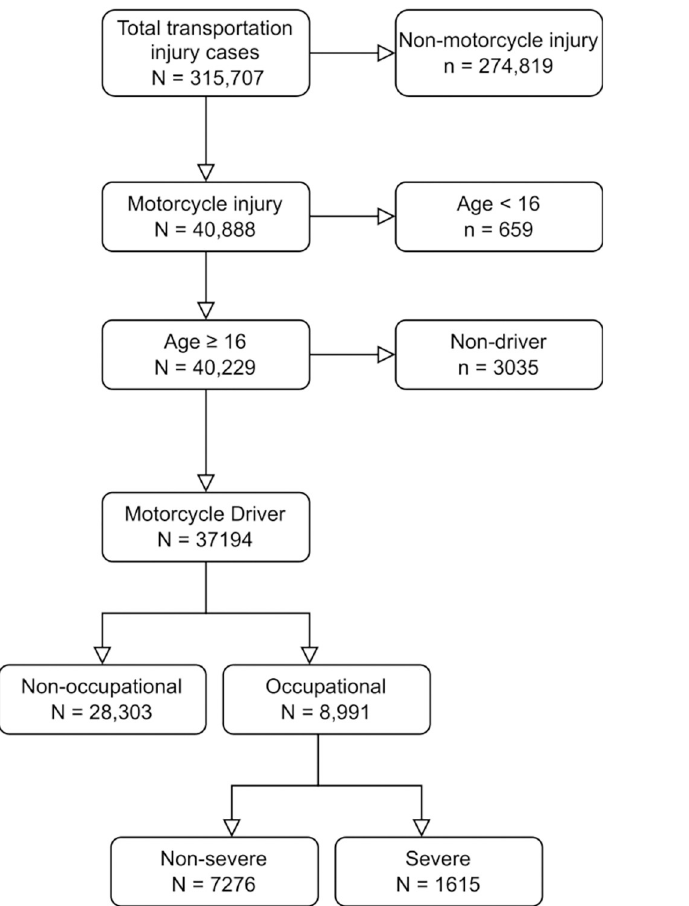
Fig 1. Flow of motorcycle injury cases included in this